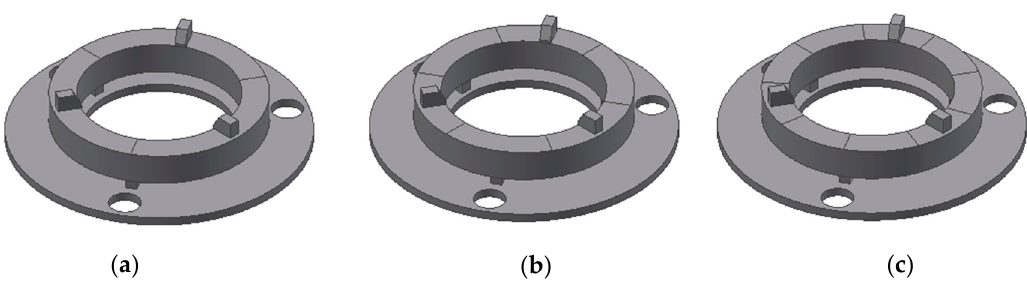
Figure 2. 3D models of the ring-shaped transducer with segmented electrodes: ( a ) 3 sectors of 120°; ( b ) 6 sectors of 60°; ( c ) 9 sectors of 40°.